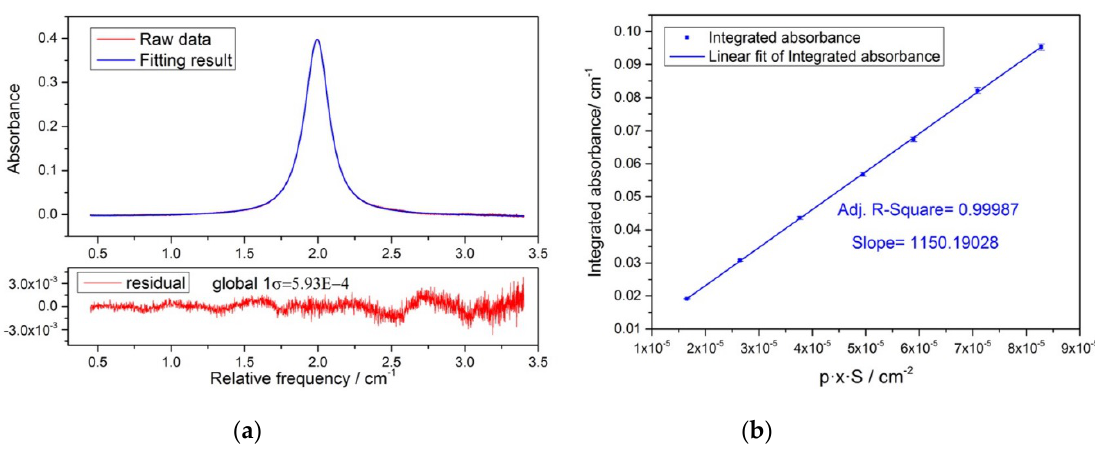
Figure 3. ( a ) Measured methane spectra together with the fitted absorption profile (blue line) and fit residuals, Global 1 σ indicates the standard deviation of the residuals in the whole spectral window. ( b ) Straight line fit to the integrated absorption. The slope of the fitting line is the optical path length of the multipass absorption cell.